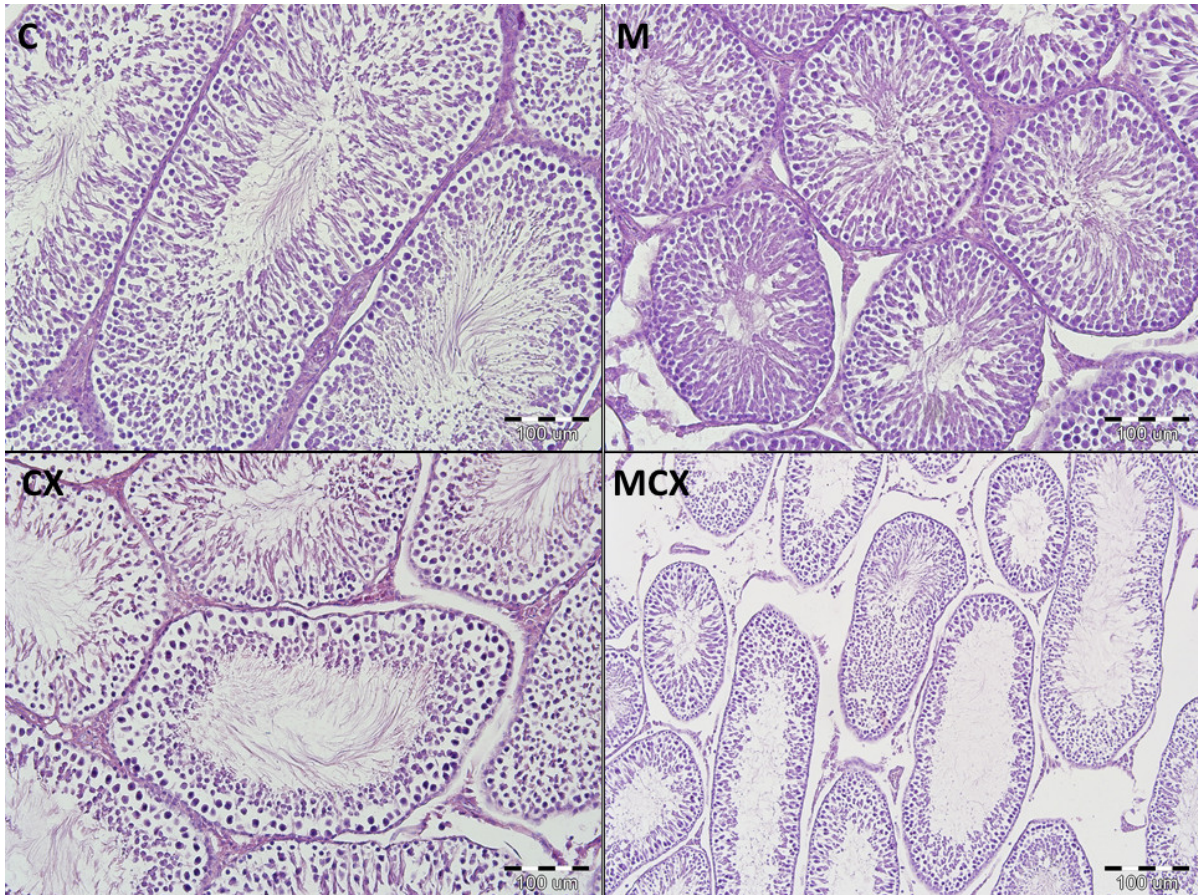
Figure 3. Histological cross-sections of testes (HE staining, magnification 200×). C—control group—appearance of normal testis with orderly maturation of germ cells from the base to the center of the lumen: numerous spermatogonia (along the basement membrane), primary and secondary spermatocytes, spermatids, and spermatozoa; M— Morin-5′-sulfonic acid sodium salt (NaMSA) receiving group—appearance of normal testis: the seminiferous tubules with numerous germ cells; CX—cyclophosphamide receiving group—changes grade 2—the seminiferous tubules with loss of germ cells, there is an orderly maturation of germ cells from the base to the center of the lumen, but the number of spermatogonia (along the basement membrane), primary and secondary spermatocytes, spermatids, and spermatozoa is decreased; MCX—group receiving cyclophosphamide and NaMSA—changes grade 1—the seminiferous tubules with discrete germ cells loss, there is an orderly maturation of germ cells from the base to the center of the lumen, but the number of spermatogonia (along the basement membrane), primary and secondary spermatocytes, spermatids, and spermatozoa is slightly reduced.